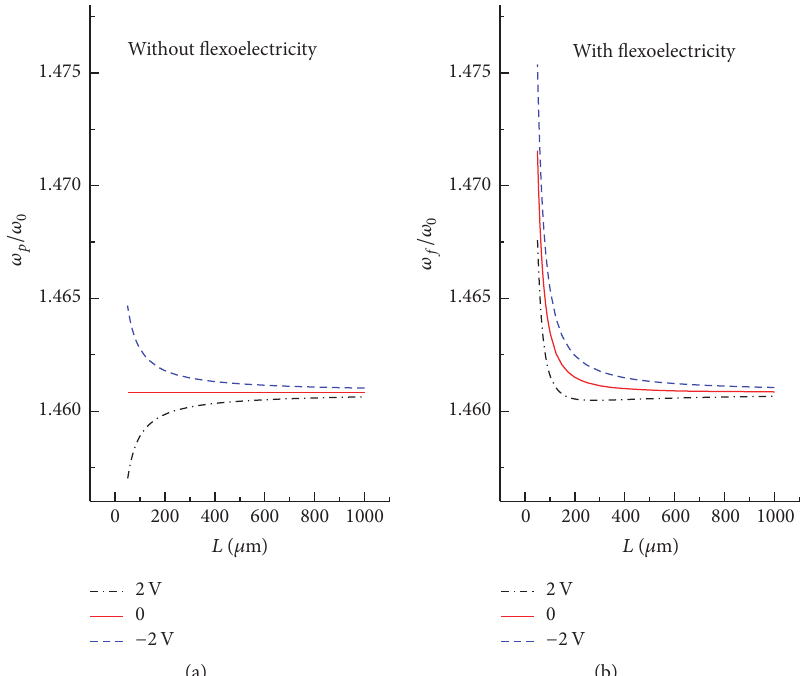
Figure 3: Length-dependence of the normalized fundamental frequency calculated for (a) 𝜔 𝑝 /𝜔 0 of PMBs with only piezoelectric effect and (b) 𝜔 𝑓 /𝜔 0 with both effects of piezoelectricity and flexoelectricity.